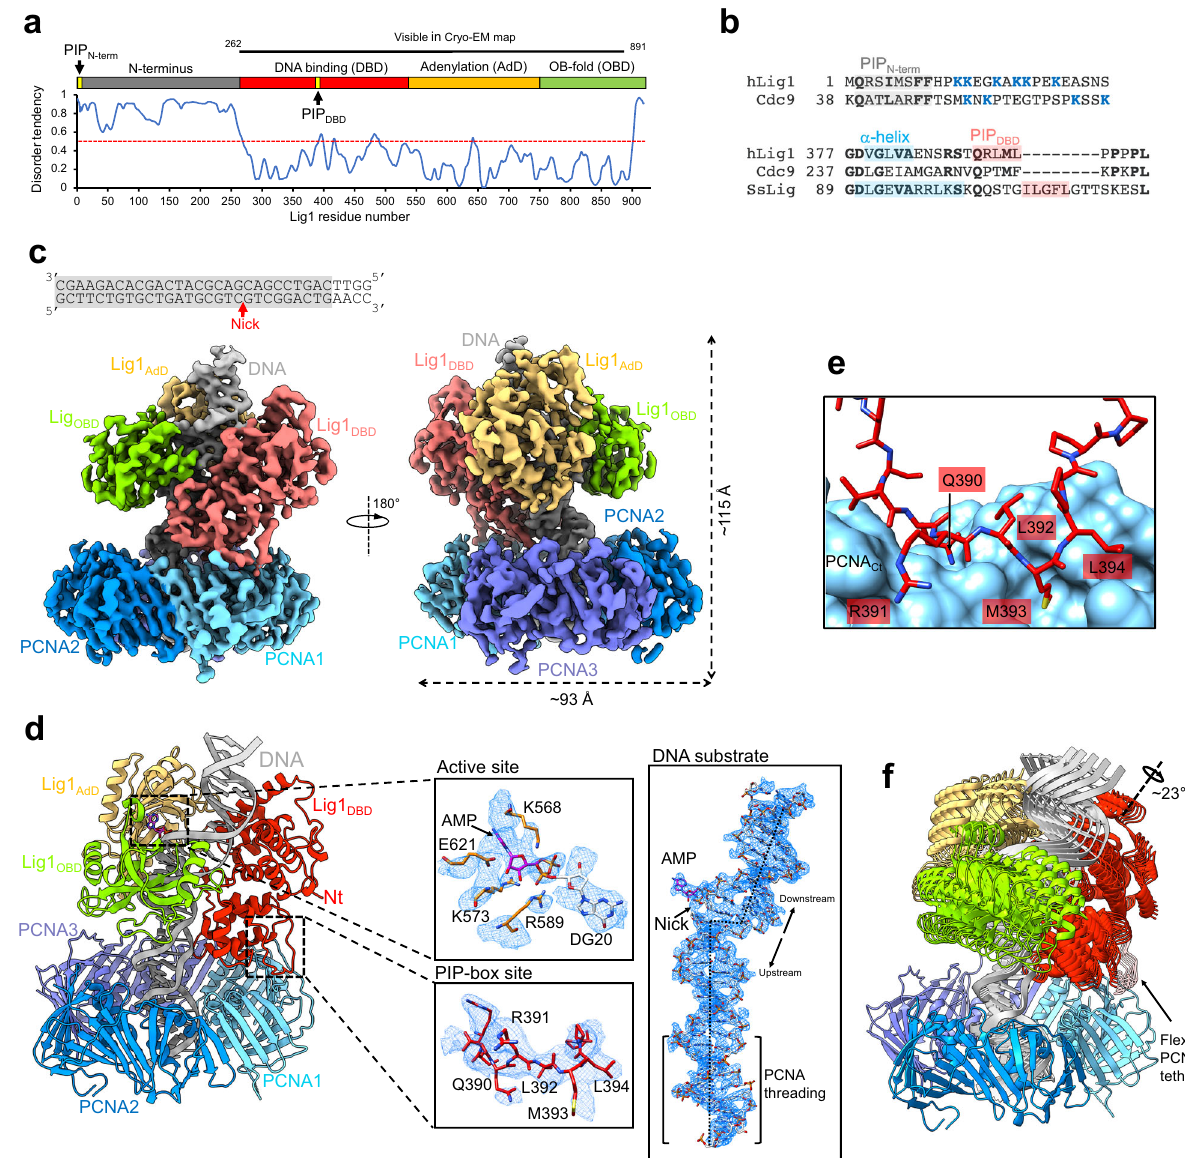
Fig.1|Cryo-EMstructureoftheLig1 – DNA – PCNAcomplex.a Disorderprediction against residue number of human Lig1, and Lig1 domain organization and position of PIP N-term and PIP DBD ; Disorder prediction was performed with PrDOS 70 . The red dotted line corresponds to a disorder tendency of 0.5. The black line corresponds to Lig1 residues visible in the cryo-EM reconstruction. b Sequence alignment of ligases at the PIP N-term and PIP DBD regions. Residues of the canonical PIP N-term are shaded in gray, C-terminal basic residues are colored in blue. Residues in α -helical conformation at the N-terminus of PIP DBD in human Lig1 and ssLig 18 cryo-EM structures are shaded in blue. c Two views of the cryo-EM density map of the Lig1 − DNA − PCNA complex colored by domains. The sequence of the nicked DNA substrateusedinthestudyisshown.Theregionshadedingraycorrespondstothe nucleotides modeled in the structure. The red arrow indicates the position of the